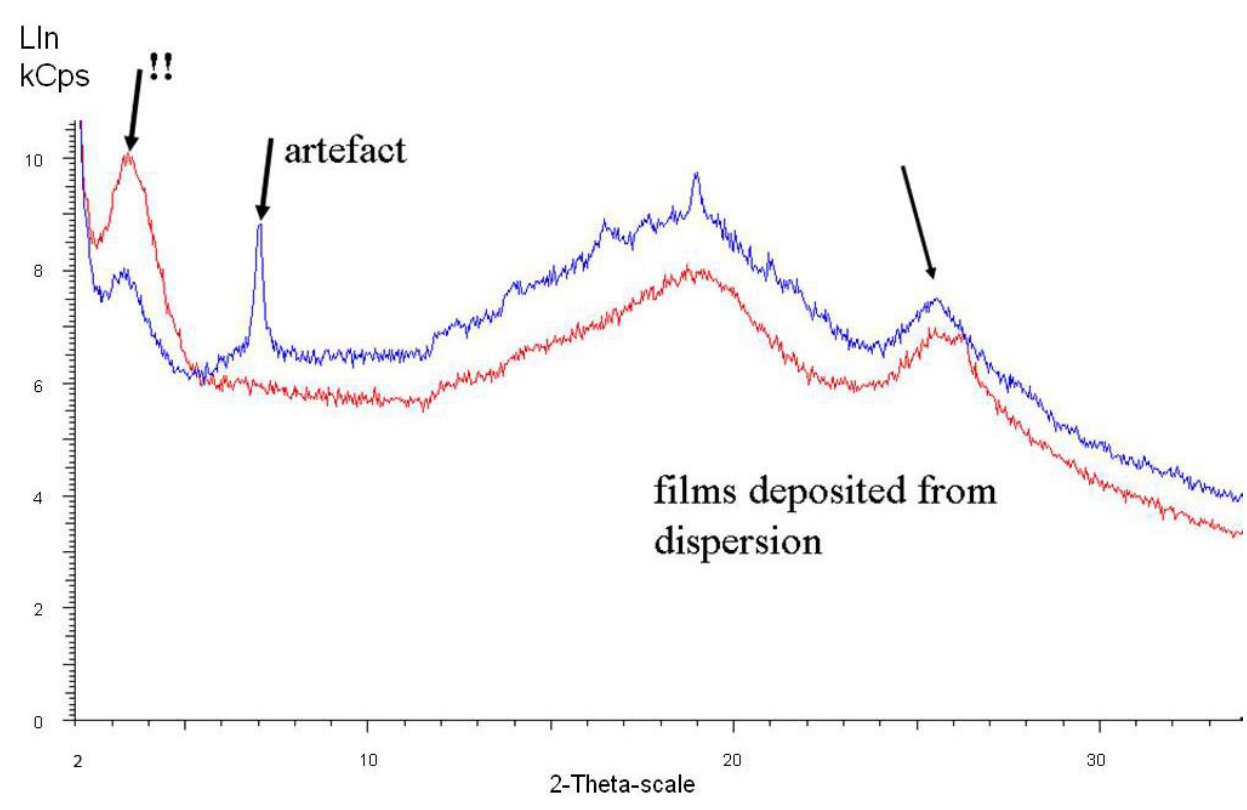
Figure 7. X-ray diffraction of polyaniline films deposited after completed dispersion steps. The blue curve represents a film having 50 S/cm, the red curve 100 S/cm